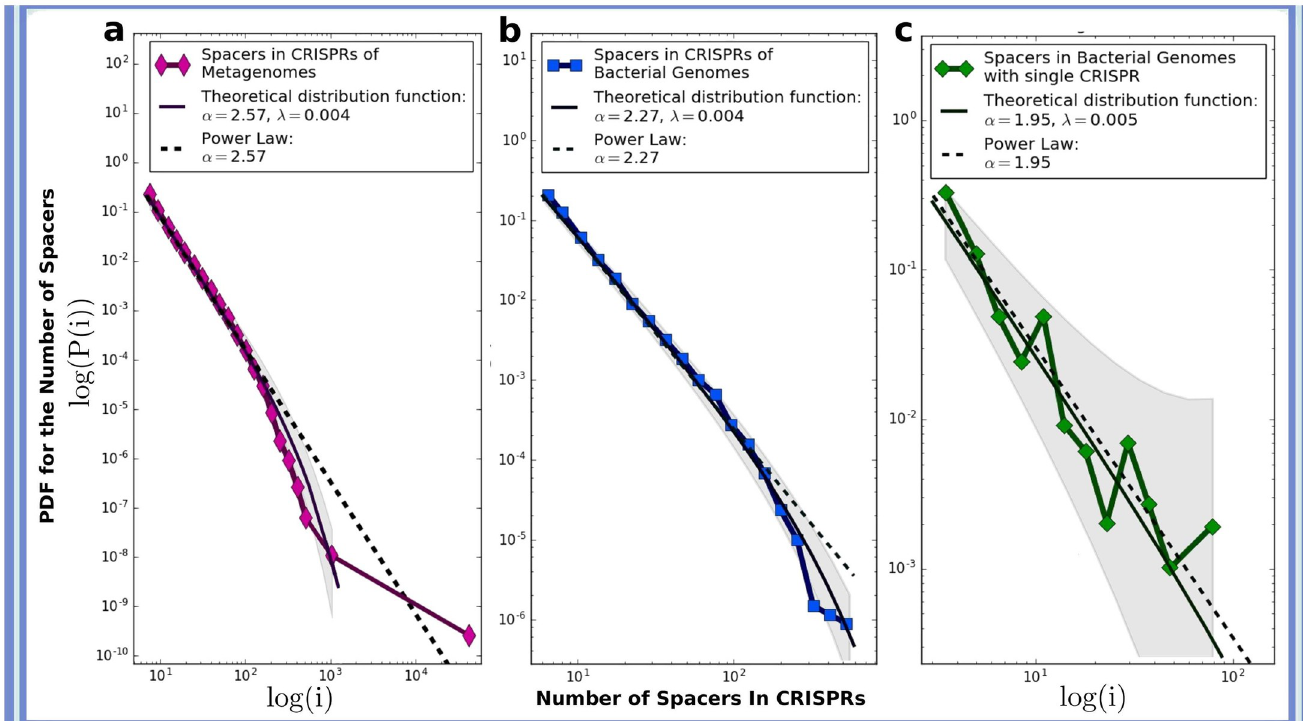
Fig 3. Spacer distributions in empirical genome sequences generally exhibit power law behaviour. Statistical distribution of the number of spacers across CRISPR arrays in the data combined from ( a ) 3,858 metagenomes, ( b ) 6,214 complete archaeal and bacterial genomes, ( c ) 237 complete genomes possessing only a single CRISPR array. The curves are fitted using the power law function with an exponential decay p ( i ) * i − α e − λ i and are shown by solid lines. The dashed line shows the slope of the power law function. The shaded area shows 95% confidence bands.